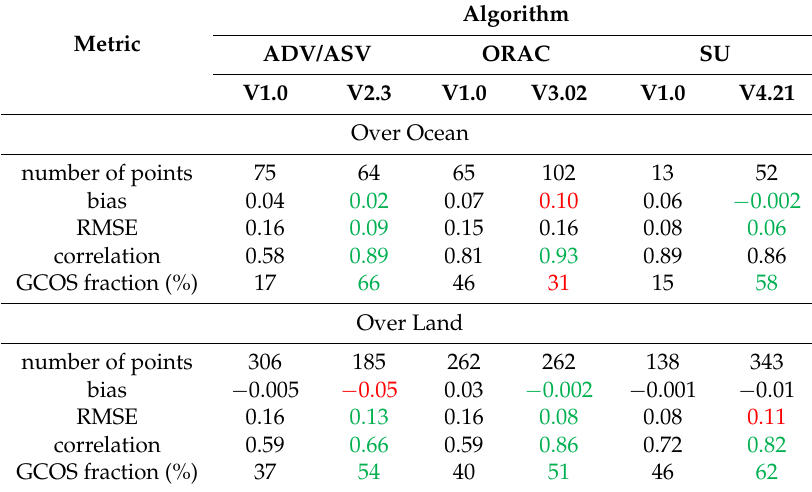
Table 3. Validation of the oldest and latest versions of the three AATSR (Advanced Along-Track Scanning Radiometer) AOD (aerosol optical depth) datasets vs. AERONET (Aerosol Robotic Network) AOD for September, 2008. Improved metrics are highlighted in green, metrics which became worse are in red colors. Algorithm Metric ADV/ASV ORAC